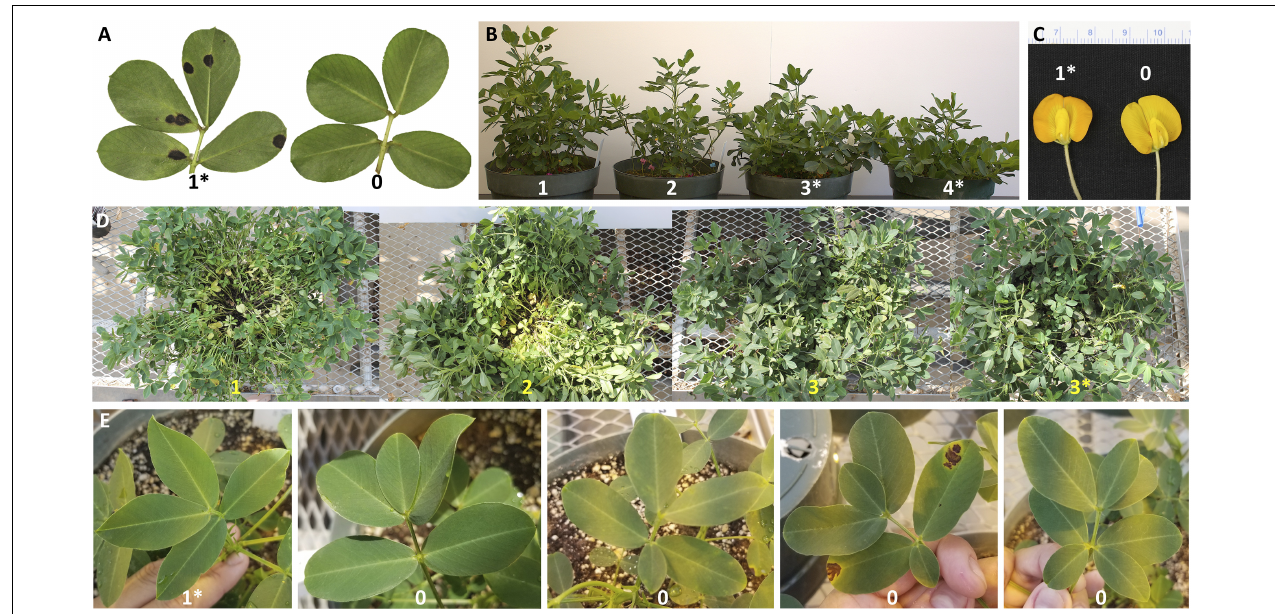
FIGURE 2 | Phenotypic characterization of advanced backcross population. Leaf spot incidence for BC 3 F 1 s and BC 3 F 2 s [“yes” (1) or “no” (0)] (A) ; architecture for BC 3 F 1 s and BC 3 F 2 s (scores: 1 – erect, 2 and 3 – intermediate, 4 – prostrate, and 5 – dwarf phenotype observed only for BC 3 F 2 generation) (Pittman, 1995) (B) ; flower color for BC 3 F 1 s (scores: Orange – 1 or yellow – 0) (C) ; variation in branching for BC 3 F 2 s (scores: 1 – high, 2 – intermediate and 3 – normal) (D) ; 1–3 extra leaves in leaflets for BC 3 F 2 s (score 0) (E) . “ ∗ ” indicates A. hypogaea phenotype in all the